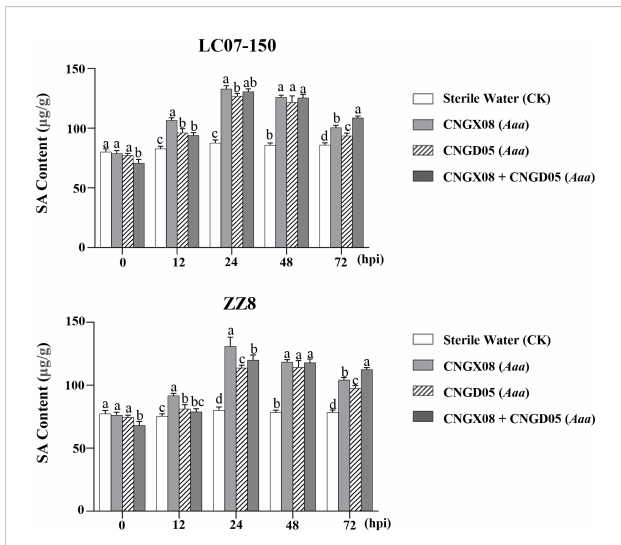
FIGURE 4 Salicylic acid (SA) content in two sugarcane varieties (LC07-150 and ZZ8) inoculated with strains CNGX08 and CNGD05 of Acidovorax avenae subsp. avenae ( Aaa ). Inoculated leaf samples were collected 0, 12, 24, 48, and 72 hours post inoculation (hpi). Each vertical bar represents the mean ± standard deviation of three biological and three technical replicates per subsample. At each time point, means with the same letter are not signi fi cantly different at P = 0.05 according to Duncan ’ s test.